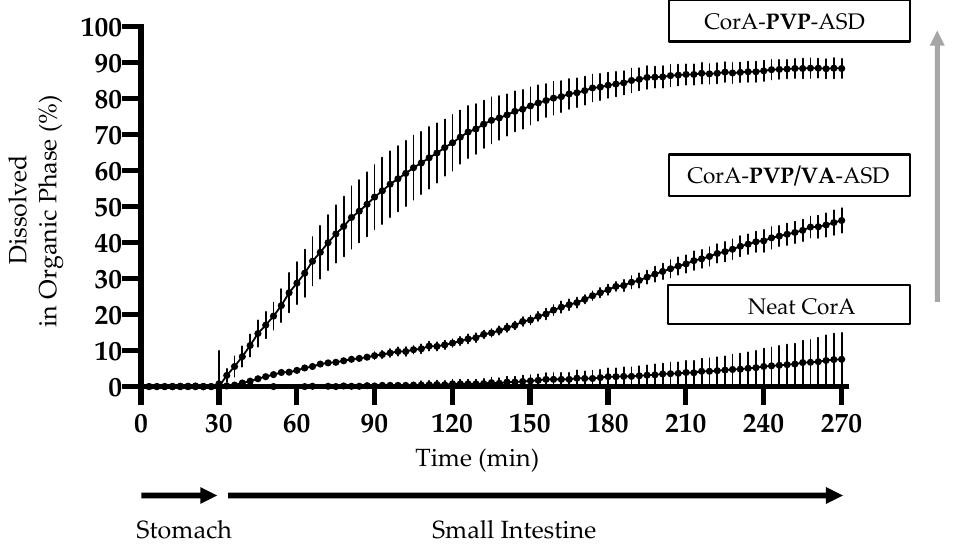
Figure 11. Increase of fraction absorbed into organic phase: Neat CorA < CorA-PVP/VA ASD formulation < CorA-PVP ASD formulation.